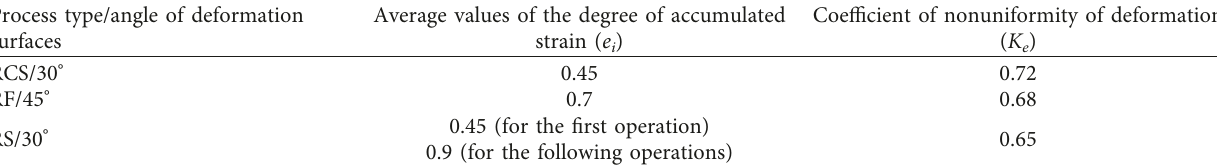
Table 1: The values of the workpieces’ deformed state parameters in the process of SPD. Process type/angle of